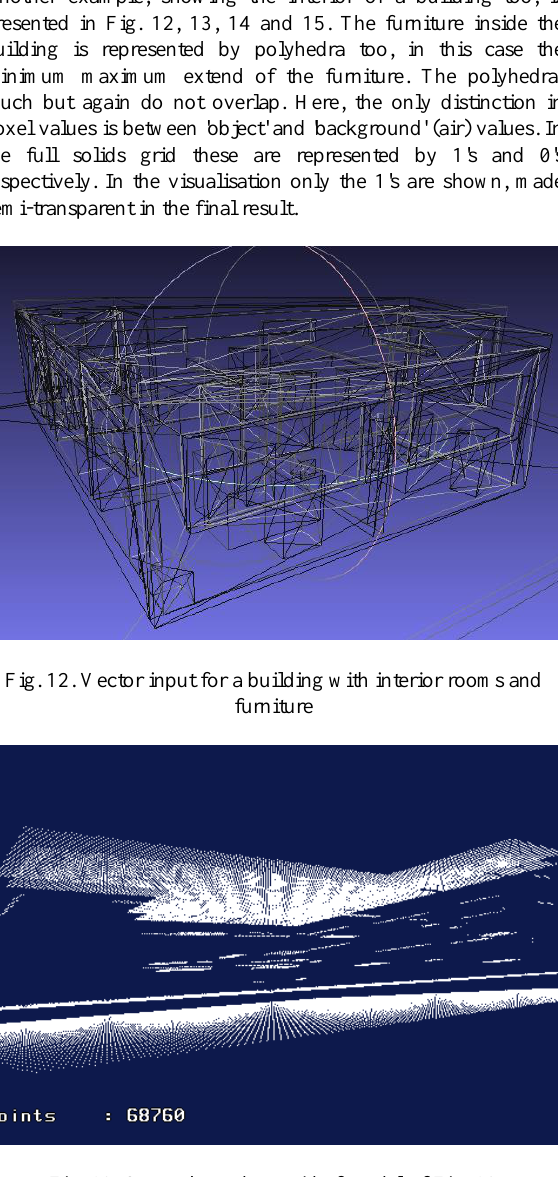
Fig. 13. Sparse boundary grid of model of Fig. 12 at 10cm grid